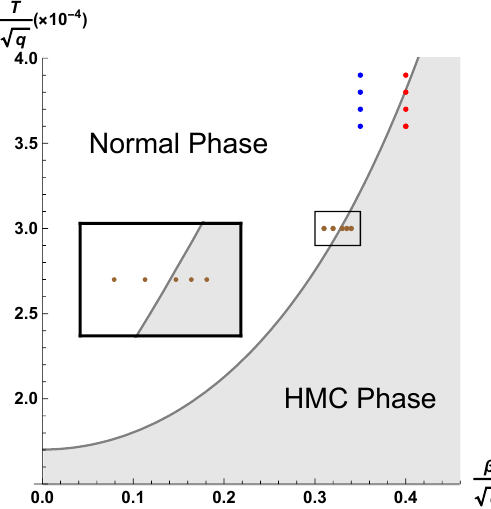
Figure 1 . This shows the phase diagram near the zero temperature. The brown dots denote √ T/ q = 3 × 10 − 4 . The corresponding transport coefficients are shown in figure 2 and 3. The blue √ and red dots represent β/ q = 0 . 35 and 0 . 4 , respectively. Their transport coefficients are shown in figure 4 and